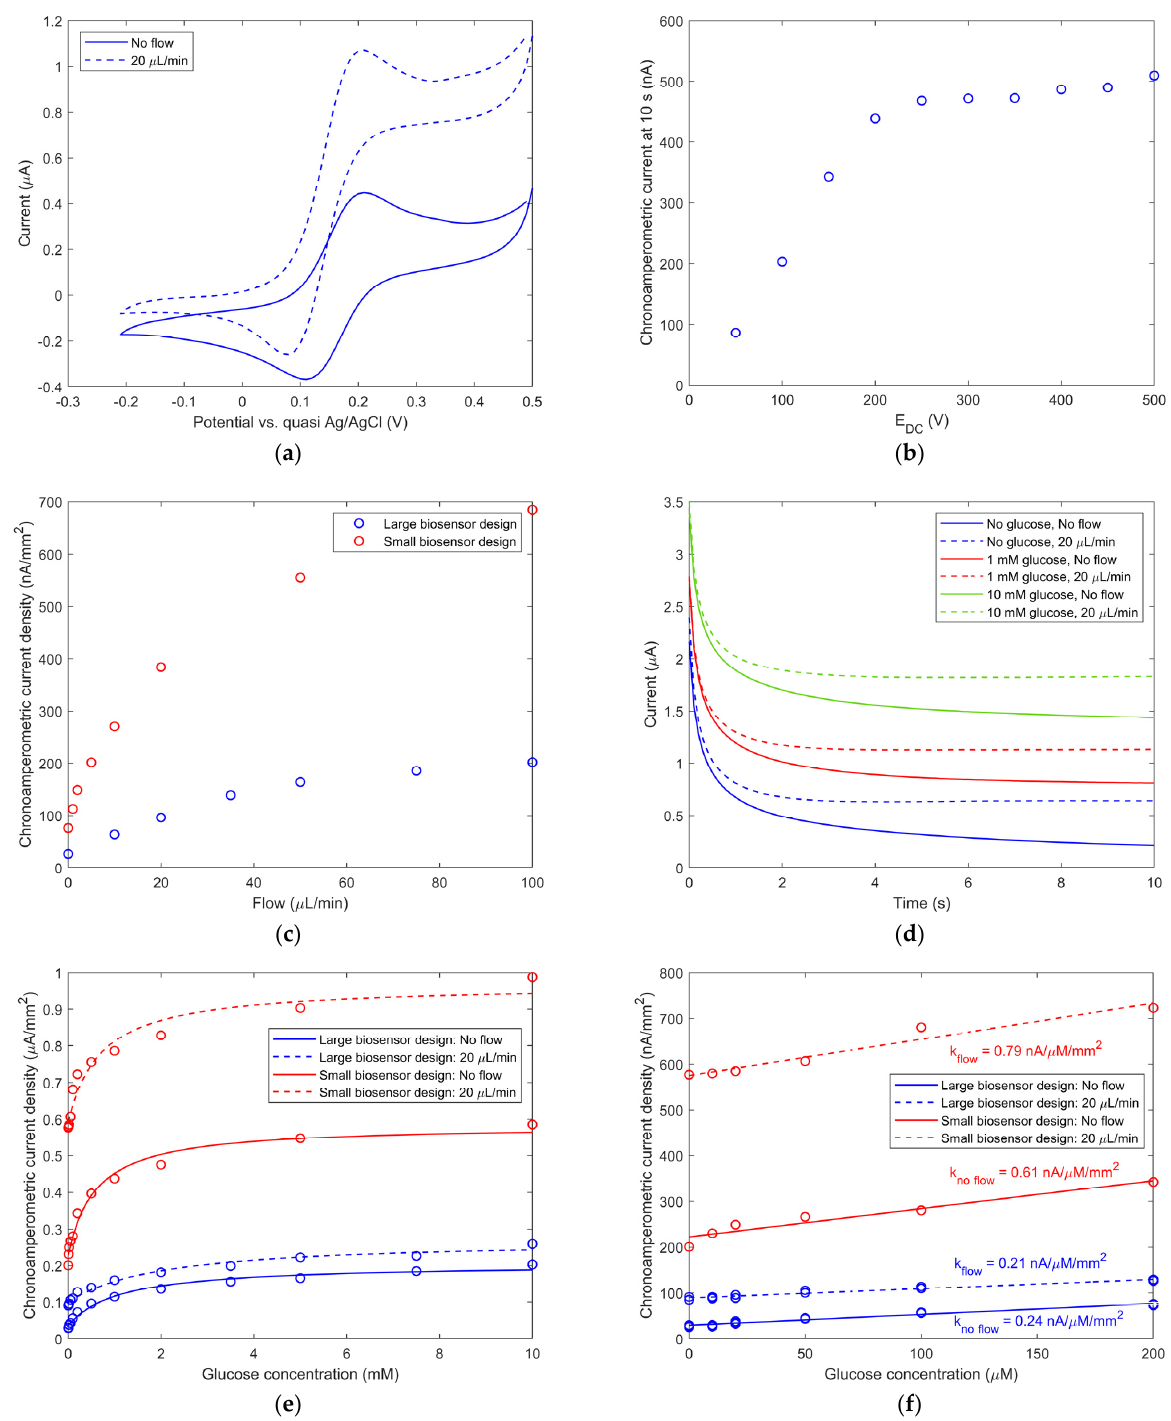
Figure 6. Characterization of microfluidic mode PQQ-GdhB biosensor: ( a ) Cyclic voltammogram obtained for zero glucose and with or without analytic solution flow; ( b ) chronoamperometric current vs. E DC potential; ( c ) chronoamperometric current density values vs. flow rate for large and small electrode design without glucose; ( d ) time-dependent chronoamperometric current of large electrode design for various glucose concentrations and for 0 and 20 µL/min flow rates; ( e ) biosensor response for large and small electrode design for 0 and 20 μ L/min flow rates, presenting measured values (circles) and Michaelis–Menten fitting plots (line); ( f ) linear range of biosensor response with calculated sensitivities k for glucose biosensors, presenting measured values (circles) and linear fitting plots (line).